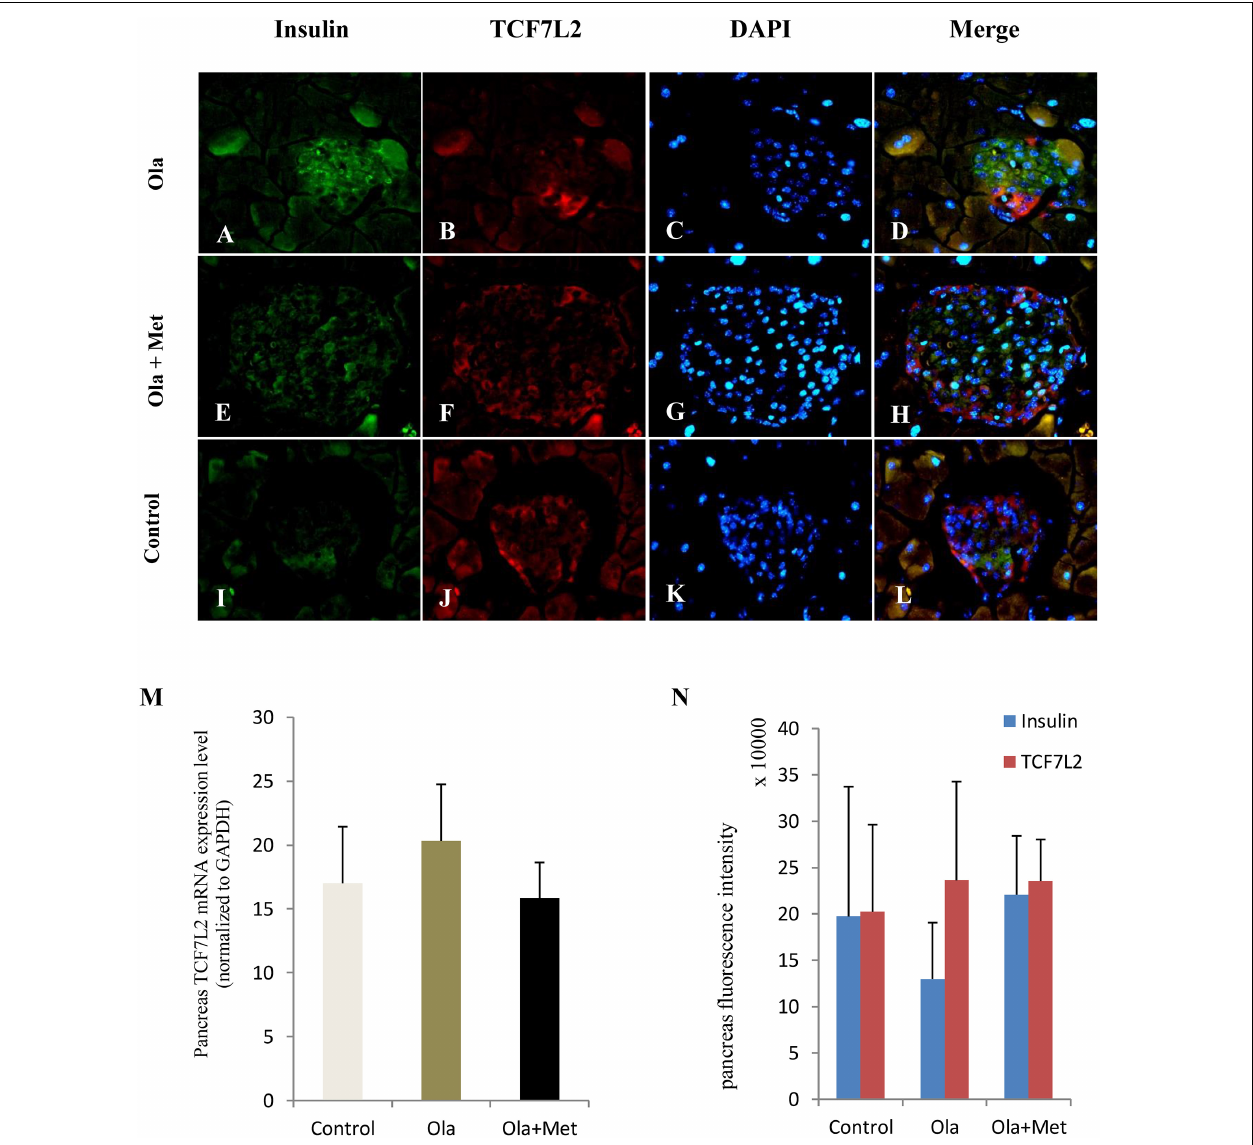
FIGURE 5 | Effect of olanzapine on expressions of TCF7L2 in pancreas islets in C57BL/6 mice. C57BL/6 mice were treated with olanzapine (4 mg/kg/day, Ola), olanzapine (4 mg/kg/day, Ola) + metformin (150 mg/kg/day, Met), or saline for 8 weeks. (A–L) Representative images of immunofluorescence images of islets stained with antibodies to insulin (green), TCF7L2 (red), and DAPI (blue). Microscopic magnification 400 × . (M) Quantitative analysis of TCF7L2 mRNA expression in pancreas islets. n = 4 for each group. (N) Quantitative analysis of TCF7L2 protein expression in pancreas islets. Values are expressed as the mean ± SEM. Total pancreatic fluorescence intensity was quantified using the Image J 1.37c. n = 4 for each